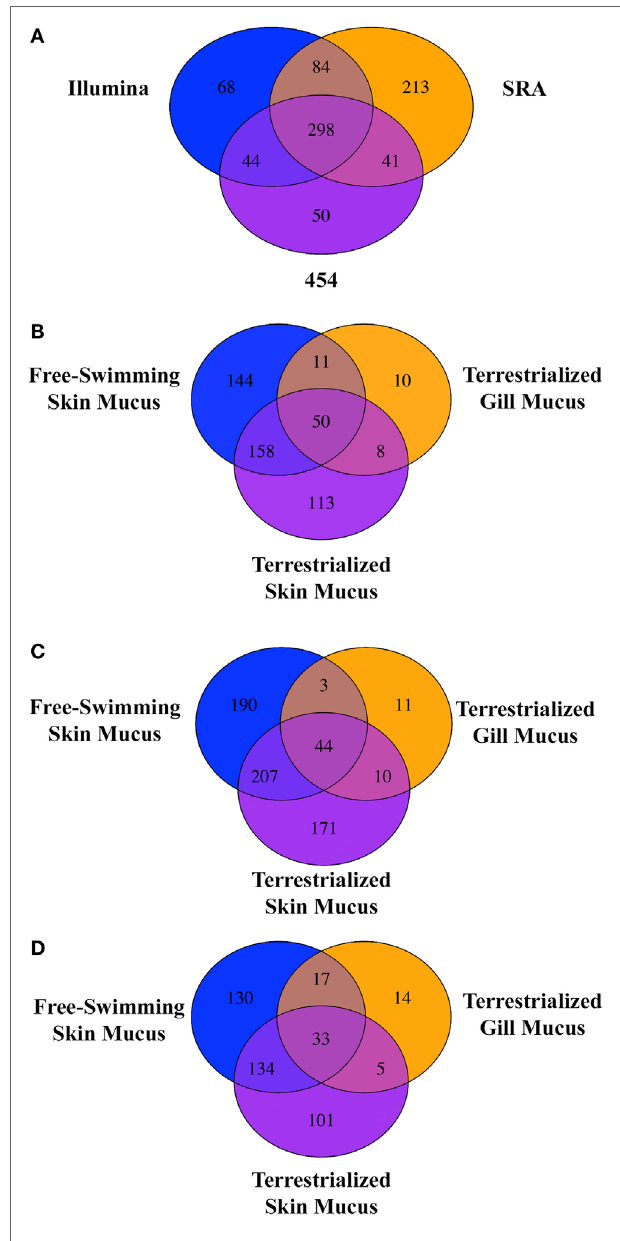
FigUre 3 | (a) Venn diagram showing the unique and shared proteins between the Illumina database, SRA database, and the 454 pyrosequencing database present in all three Protopterus dolloi mucus samples. Comparison of shared and unique proteins present in each mucus sample using the (b) Illumina database, (c) SRA database, and (D) 454